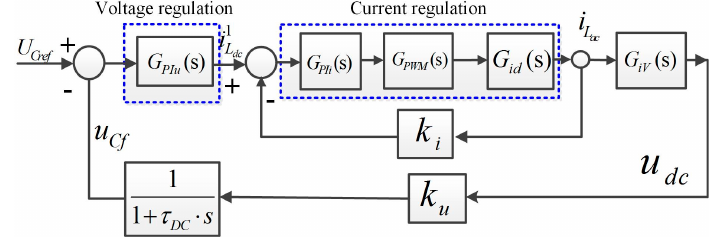
Figure 8. Control structure of DC/DC converter.